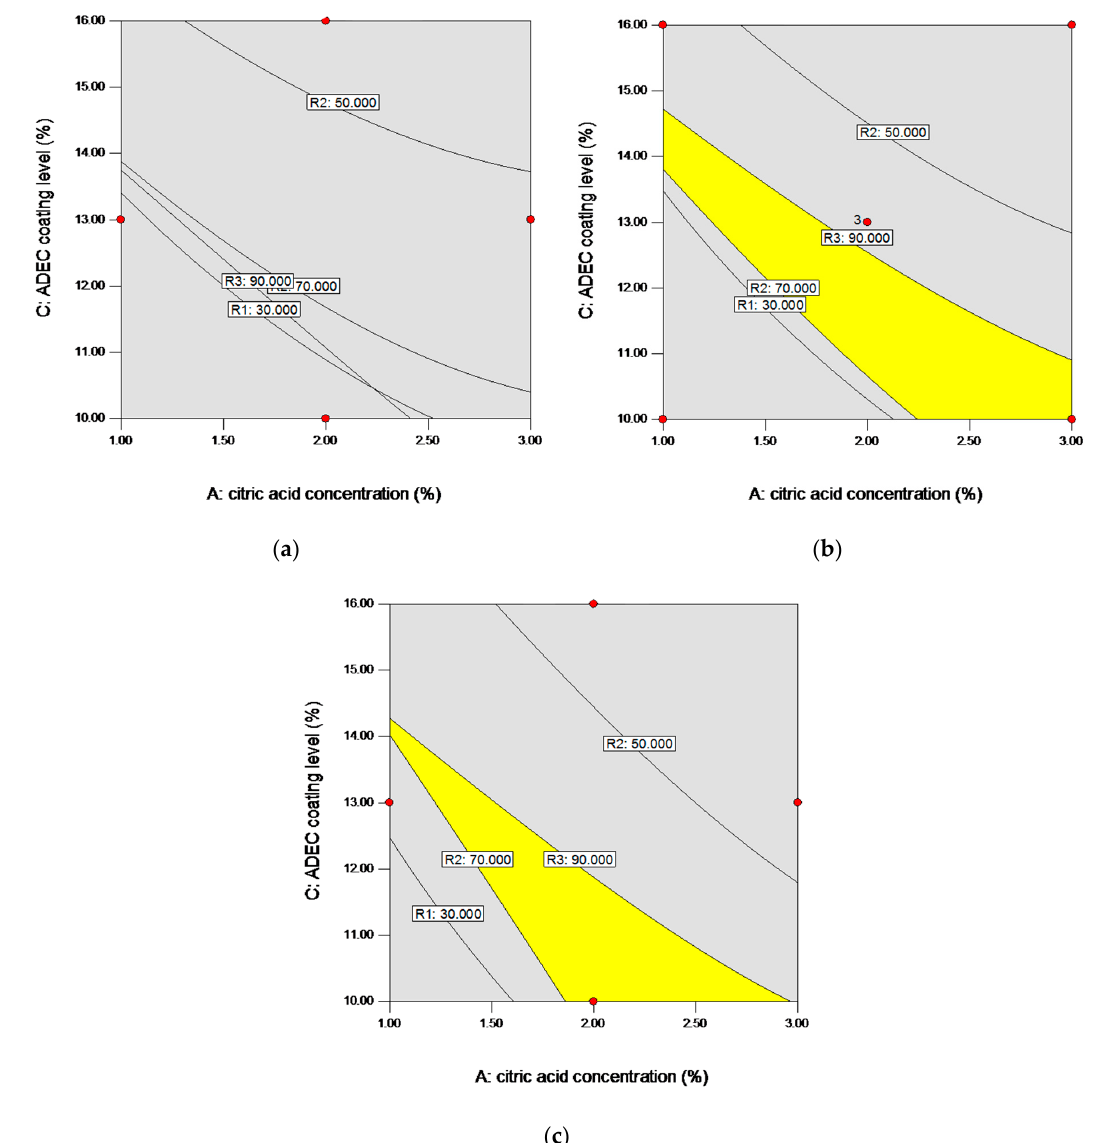
Figure 6. Design space of operating variables of the citric acid (CA) concentration and aqueous dispersion of ethyl cellulose (ADEC) coating level ( a ) at the low level of the sub-layer coating weight gain, ( b ) at the medium level of the sub-layer coating weight gain, and ( c ) at the high level of the sub-layer coating weight gain (yellow zone: design space; grey zone: failure